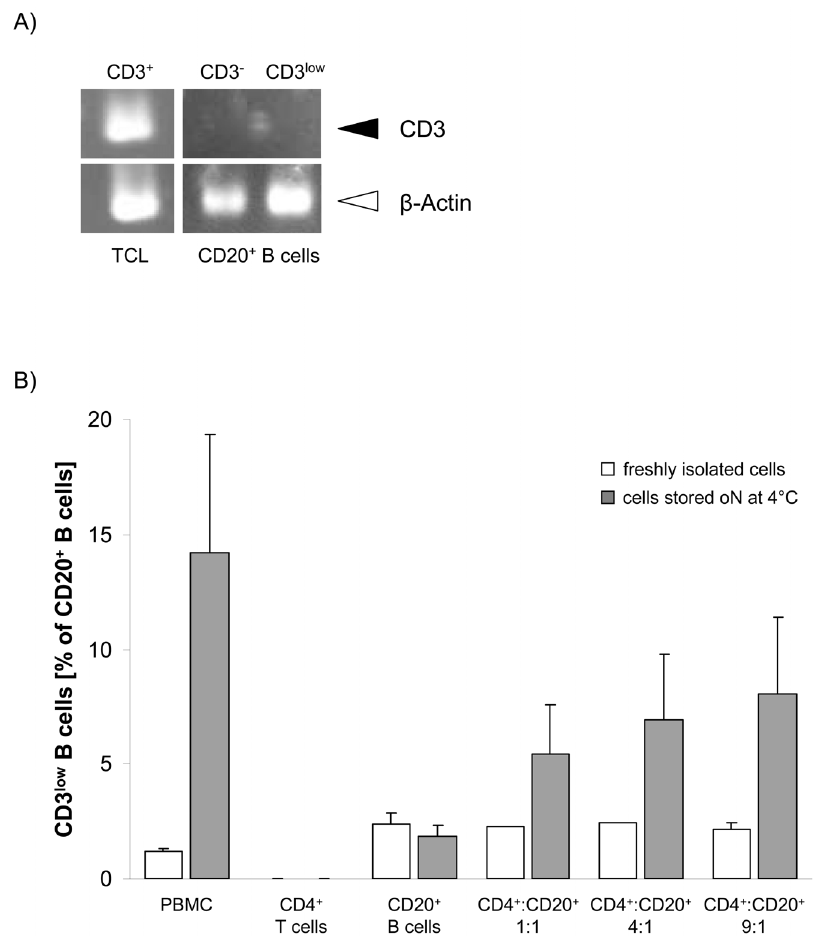
Figure 4. Detection of CD3 on B cell surfaces is a result of cell number- dependent T-B cell interactions. Semiquantitative RT-PCR for CD3 was performed using RNA isolated from 7 6 10 5 MACS-purified CD20 + B cells and a CD3-expressing T cell line (TCL). (A) Endogenous expression of CD3 was only found in the TCL, which served as a positive control, but neither in CD3 - CD20 + nor in CD3 low CD20 + B cells. b -actin was used as loading control. (B) The appearance of CD3 low CD20 + B cells was demonstrated after co-culture of MACS-purified CD4 + T cells and CD20 + B cells in different ratios overnight (oN) at 4 u C. Storage of CD20 + B cells alone under the same conditions was not associated with an induction of the CD3 low CD20 + B cell population, pointing at the need for T cells. Furthermore, the quantity of CD3 low CD20 + B cells was dependent on the number of CD4 + T cells, i.e. increasing T-B cell ratios caused elevated numbers of CD3 low CD20 + B cells. Shown are the results of up to three independent experiments.